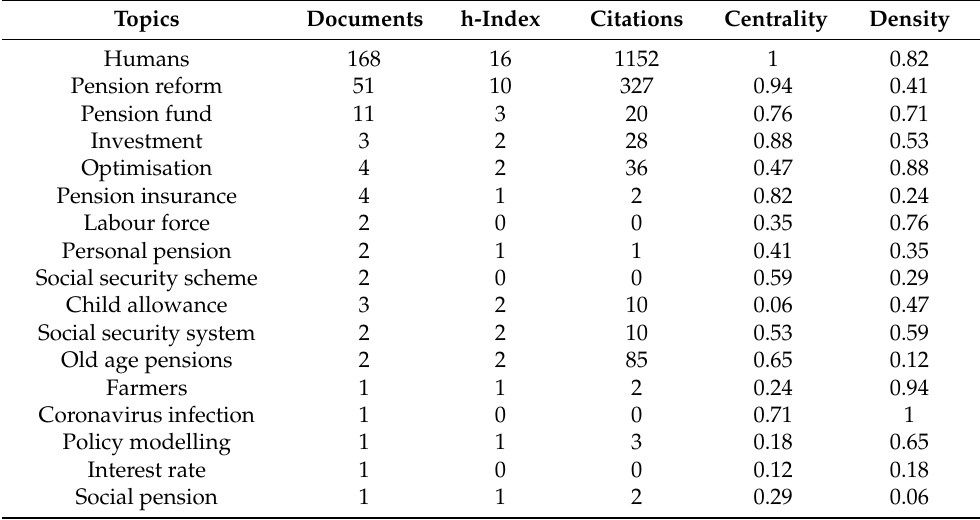
Table 10. The characteristic of the strategic diagram topics on pension research from 2011 to